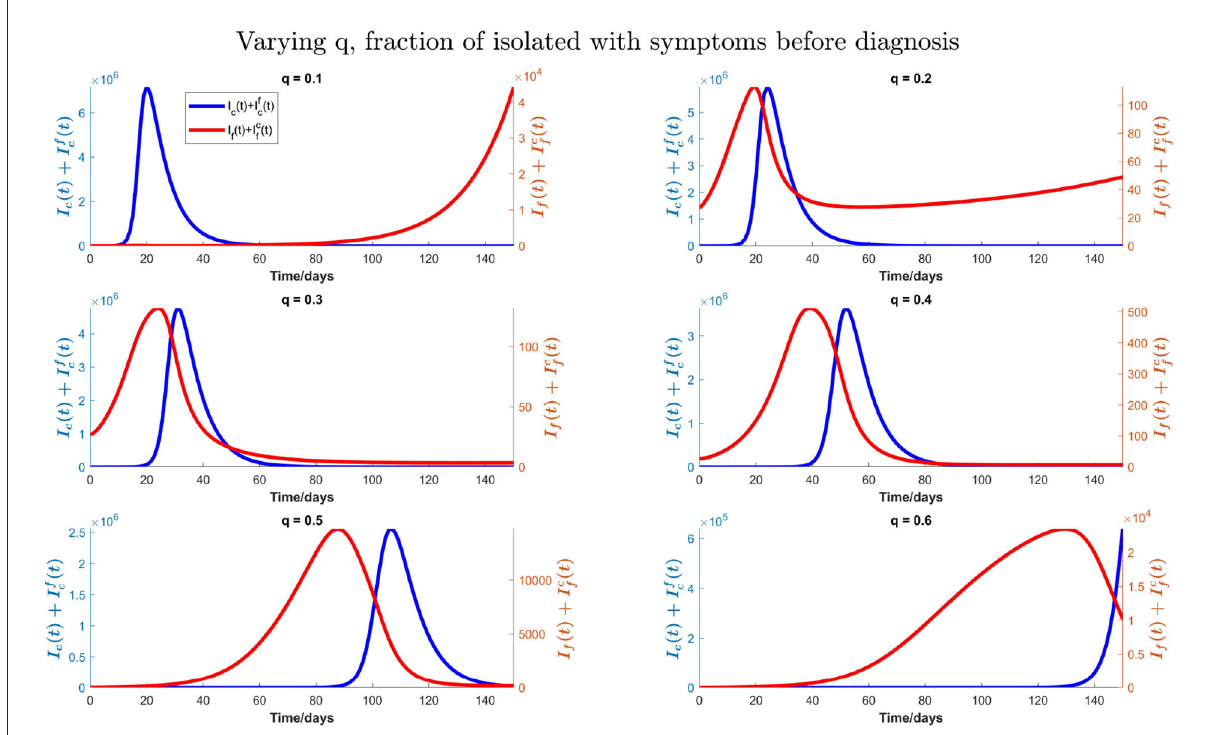
FIGURE11 Impact of varying fraction (q) of individuals who isolate them on symptoms of influenza and COVID-19 before testing on total influenza and COVID-19 infections when influenza vaccine coverage is 35%.